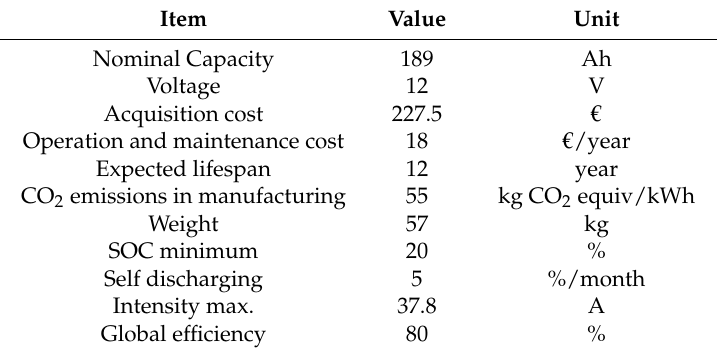
Figure 3. Cycles to failure vs. depth of discharge for a battery. Table 4. Inverter characteristics. Table 4. Inverter characteristics.